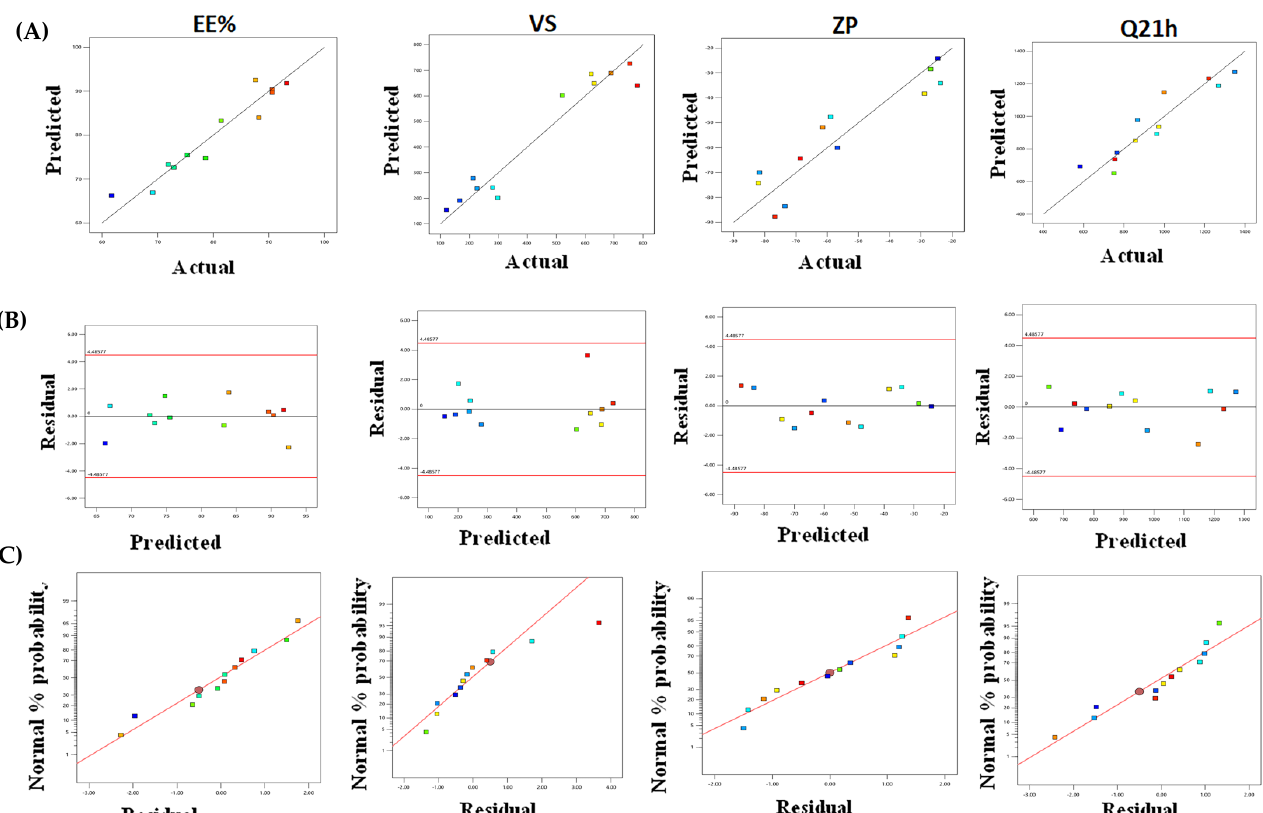
Figure 1. Model diagnostic plots of the three independent variables ( A ) linear correlation plots between actual and predicted values for various responses of DNa-BSVC, ( B ) plot of residual error vs. model predicted responses and ( C ) normal quantile-quantile plots of residual errors.